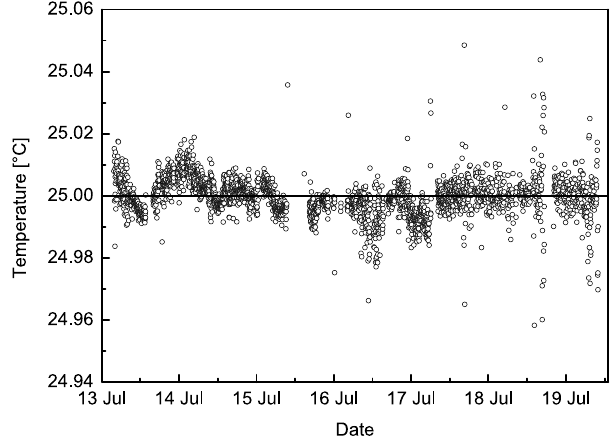
Fig. 3. Tightly controlled sample temperature at 25 ◦ C ± 0.006 ◦ C detected in the cuvette which is a main criterion for precise pH mea- surements. Temperature regulation is realized by Peltier elements in a preceding heat exchanger (see Fig. 1). Data are from a six-day period during HE331 cruise in July 2010 on R/V Heincke